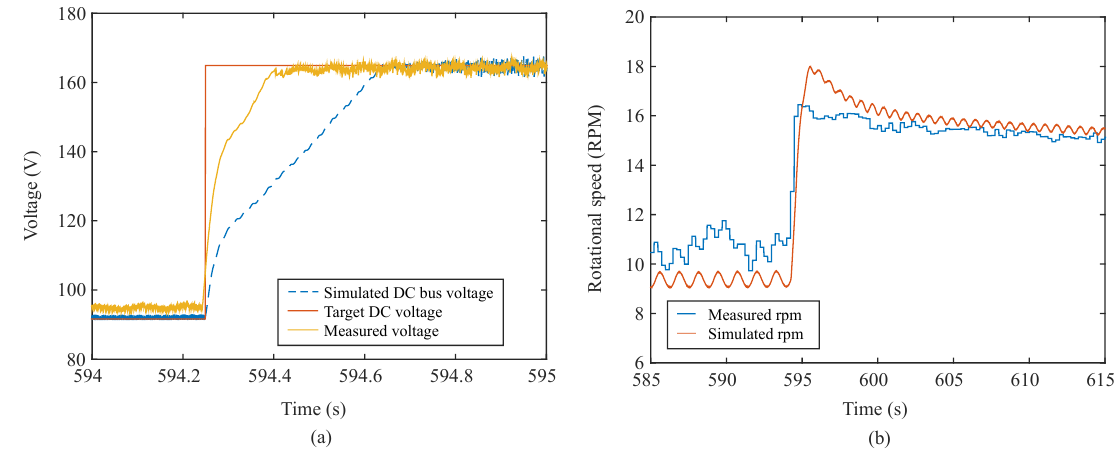
Figure 12. Simulated and experimental step response of turbine operation close from low to high λ : ( a ) DC bus voltage; ( b ) Rotational speed of the